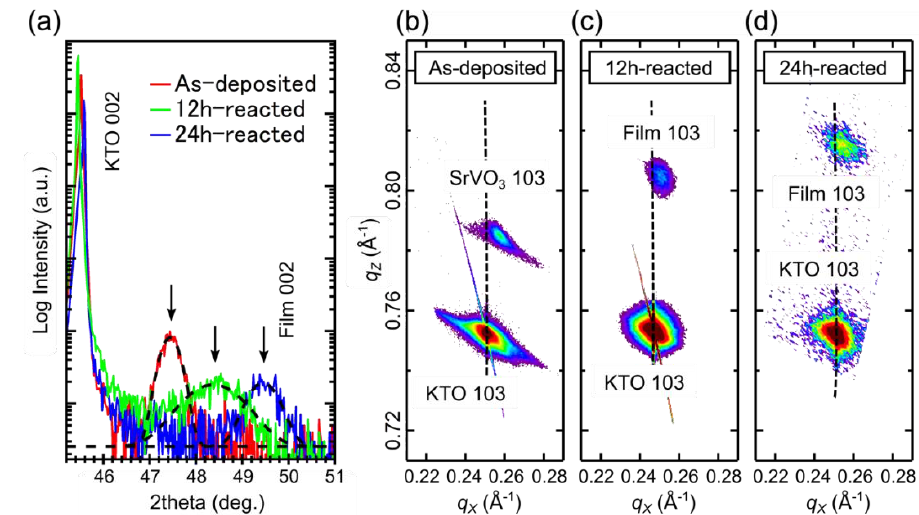
Figure 2. ( a ) XRD θ –2 θ scans around the 002 peaks of the as-deposited, 12h-reacted, and 24h-reacted SrVO 3 thin films on the KTaO 3 substrates. The broken lines represent Gaussian fits. ( b – d ) RSM around the 103 reflections for the as-deposited ( b ), 12h-reacted ( c ), and 24h-reacted ( d ) SrVO 3 thin films.